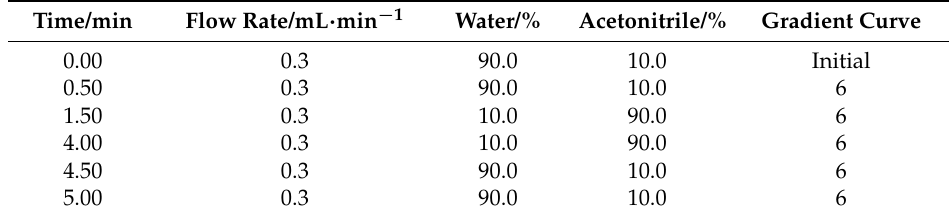
Table 2. Gradient elution program of the mobile phase.